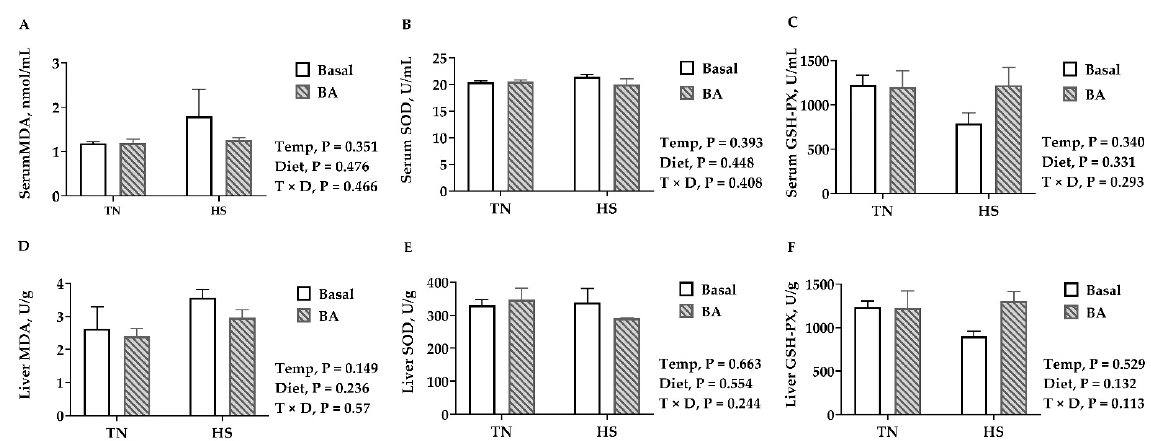
Figure 3. Oxidative damages parameters and antioxidative enzymes in the serum and liver of broilers fed with 0 or 200 mg/kg bile acids under thermoneutral (TN) and heat-stressed (HS) conditions. ( A , D ) Malondialdehyde (MDA); ( B , E ) superoxide dismutase (SOD); ( C , F ) glutathione peroxidase (GSH-Px). Data are the means ± SEM (n = 6 for each group).